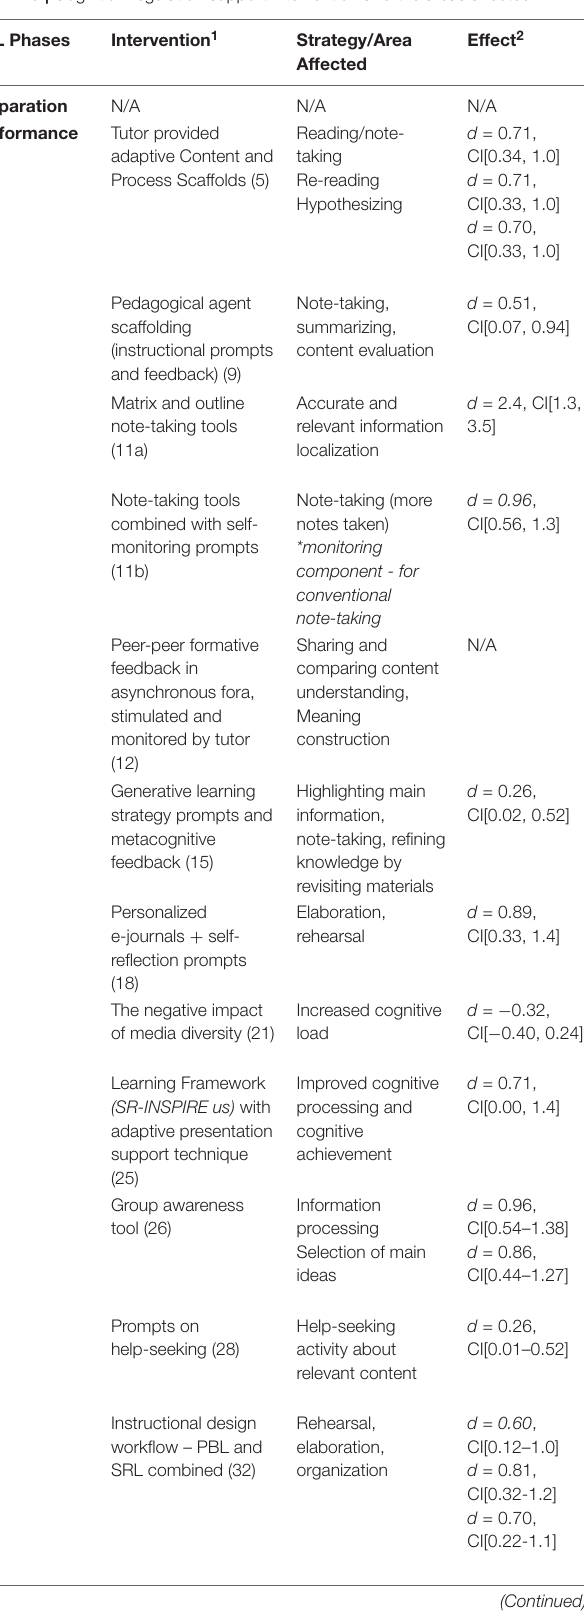
TABLE 3 | Cognition regulation support intervention and the areas